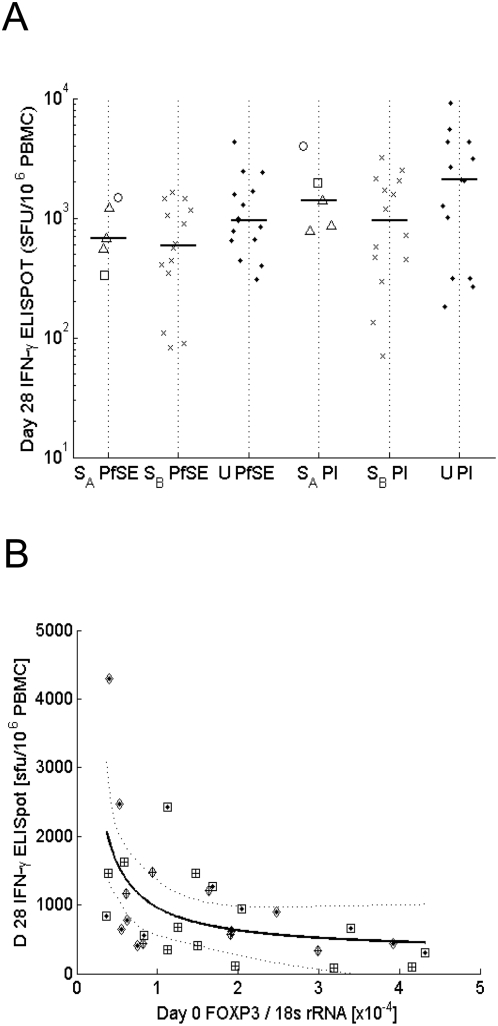
Tregs induced during the clinical episode under study limit the magnitude of subsequent malaria-specific IFN-γ memory responses.(A) PBMCs collected on day 28 were cultured for 6 days with PfSE, uRBC, P+I or GM, respectively, and assayed in an IFN-γ ELISpot to measure the magnitude of the malaria specific memory response. Background levels of IFN-γ production obtained in uRBC or GM were deducted from PfSE or PI. (B) cultured IFN-γ ELISpot responses to PfSE (D 28) are plotted against FOXP3 mRNA levels measured on day 0. A linear by linear hyperbolic fit revealed a significant association (p = 0.009). +: severe cases; ○: uncomplicated cases. Scattered lines indicate the 95% CI limits. At the 5% level there is no significant improvement in fit, using separate lines for severe and uncomplicated patients. No significant effect of parasitaemia could be observed. Depending on a parasitaemia level above or below the median parasitaemia in both groups, a diamond (high) or a square (low) was added to individual data points to illustrate this.